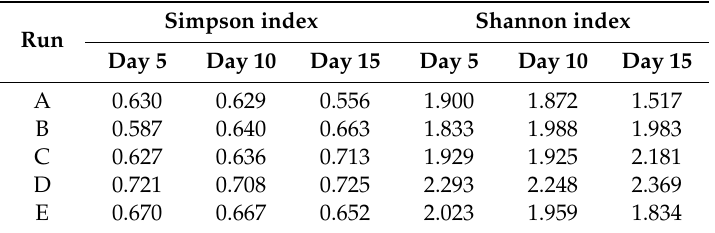
Table 2. The Simpson and Shannon indices of microbial communities in the family level.